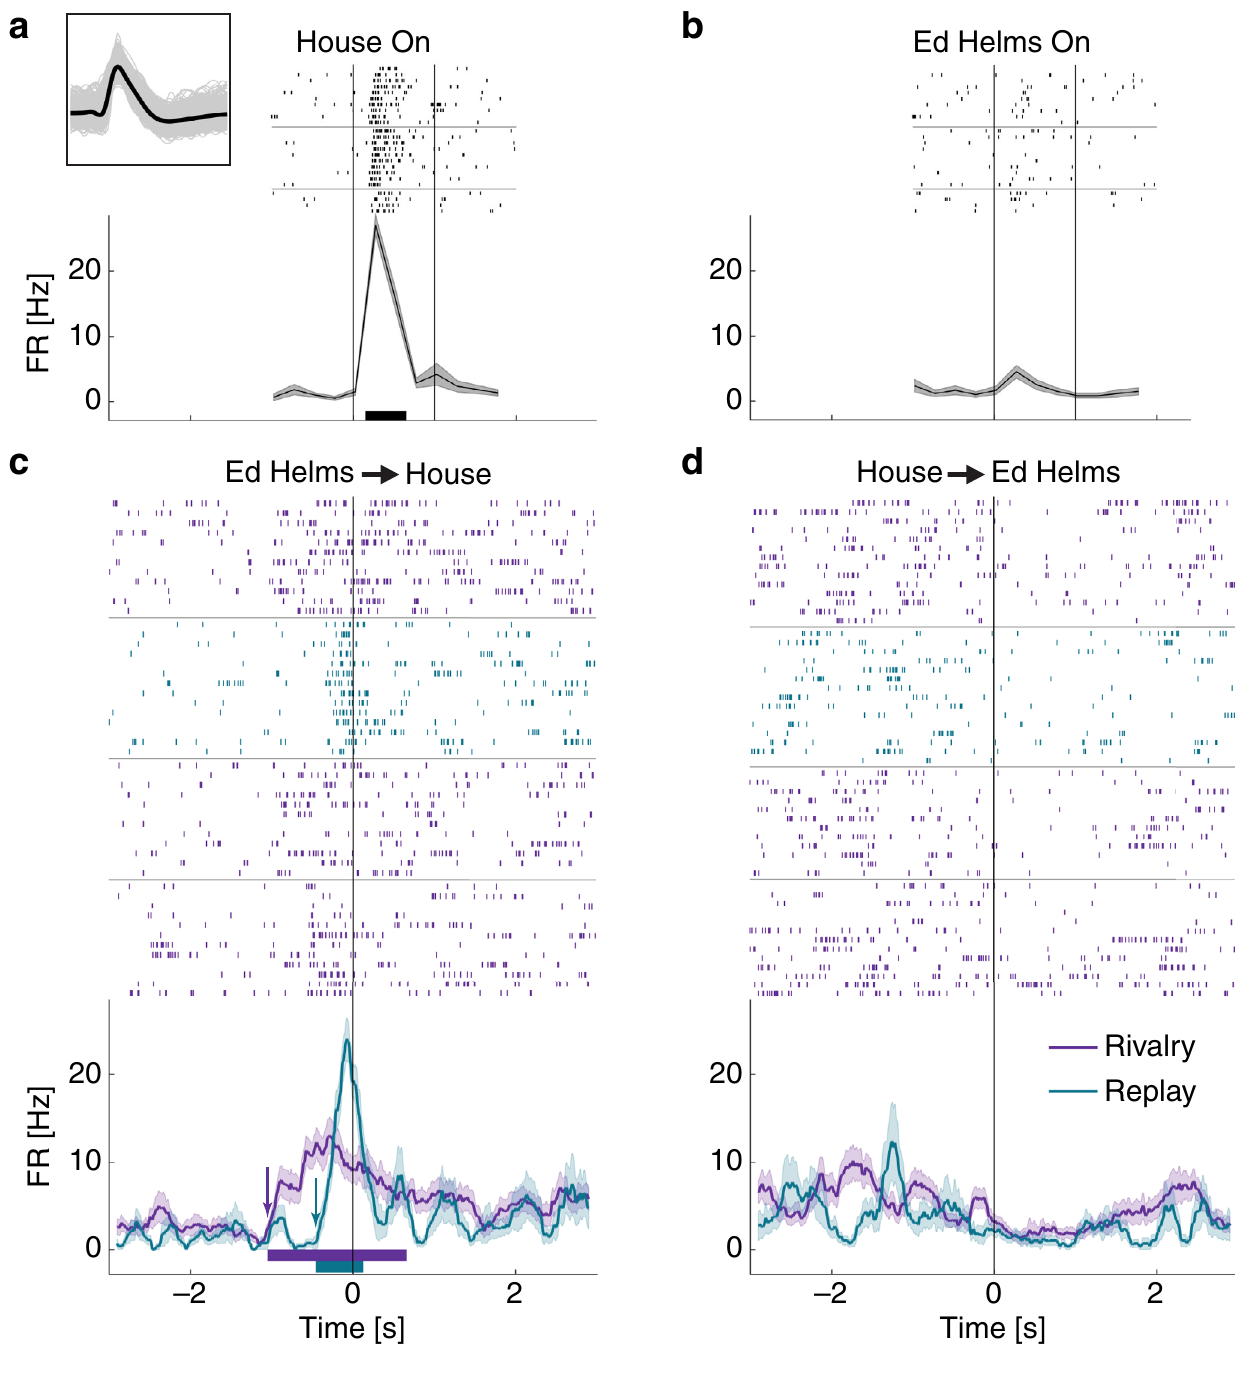
Fig. 2 Activity of a single-unit in parahippocampal gyrus during rivalry and replay. a , b Responses to the non-rivalrous presentation of a house ( a ) or the actor Ed Helms ( b ) images. Raster plots (order of trials is from top to bottom) and post-stimulus time histogram (PSTH; 250 ms bins) are given for each image; vertical lines indicate image onset and offset; horizontal lines separate different blocks; black horizontal bars denote signi fi cant activity relative to baseline. Inset presents waveforms of this unit. c Neuronal fi ring around the report of transition onset to the house image ( t = 0; end of Ed Helms image exclusive dominance) during rivalry (purple) and replay (cyan). PSTHs are computed with a moving square-window of 200 ms. Shaded areas represent standard error (SE). Purple and cyan horizontal bars denote periods where the instantaneous FR was signi fi cantly different than baseline in rivalry and replay, respectively (onset of these periods marked by arrows). Note the earlier activation during rivalry as compared to replay. d Neuronal fi ring around the report of transition onset to the Ed helms